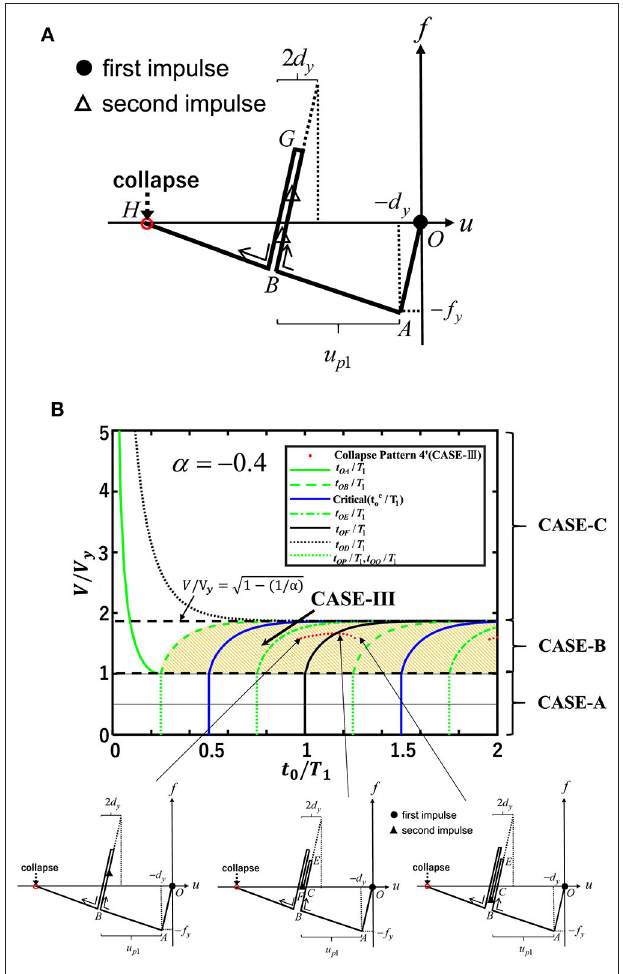
FIGURE 10 | Collapse pattern 4 ′ (CASE-B and CASE-III). (A) Second impulse timing t 0 / T 1 -input velocity relation. (B) Second impulse timing t 0 / T 1 -input velocity relation.